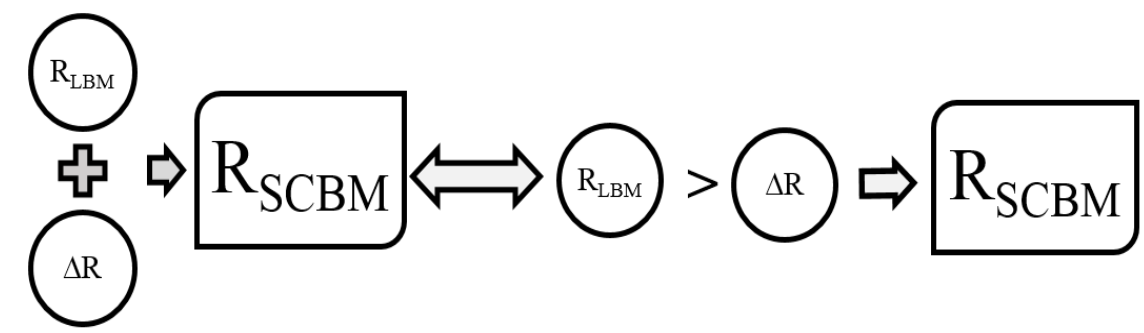
Figure 3. The relation between the magnitude of risked resources for sustainable circular business model (SCBM) and linear business model (LBM).